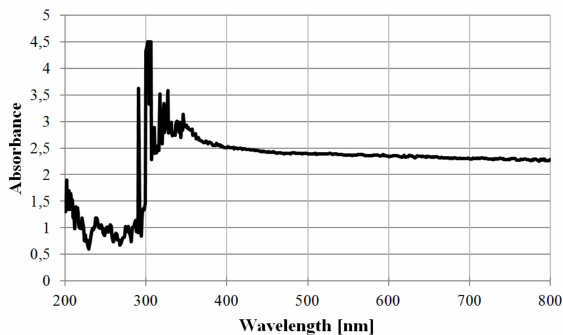
Figure 5. Spectrum of Bacillus pseudofirmus in 253